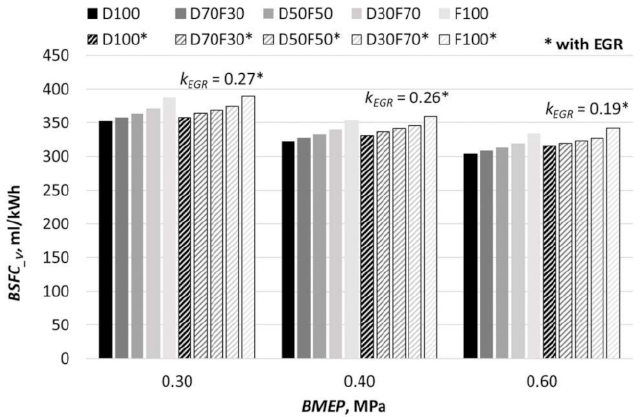
Figure 10. Dependence of brake specific fuel volume on fuel composition and the engine